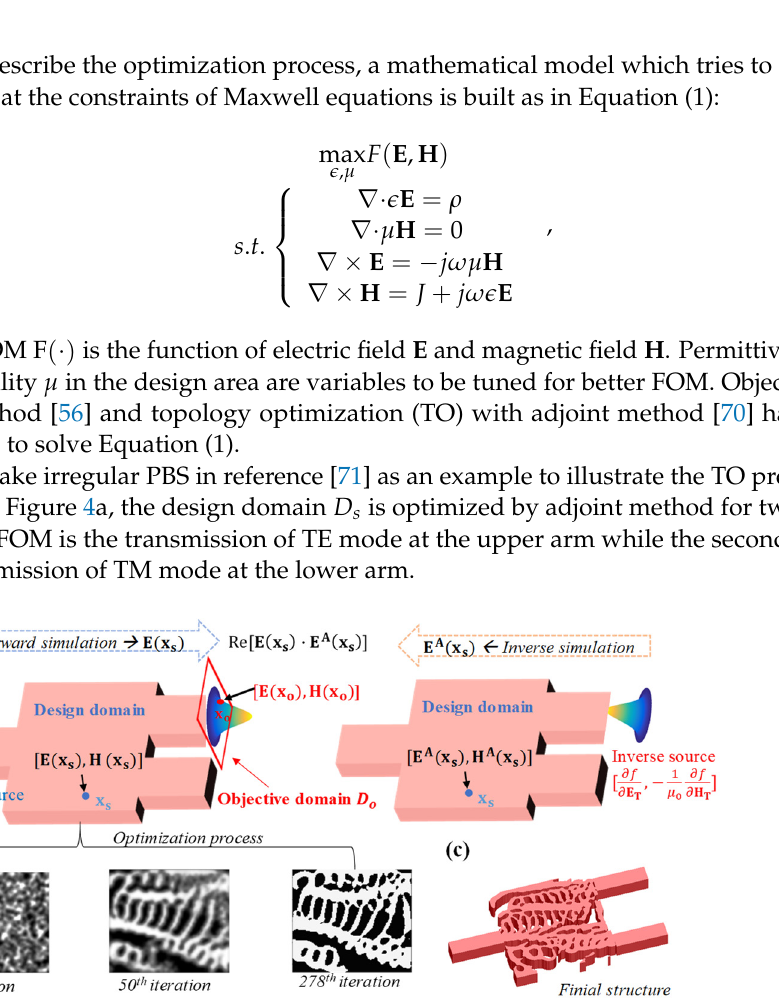
Figure 4. Topology optimization of a PBS via adjoint method. ( a ) Schematic diagram of adjoint method. ( b ) Optimization process for the design area of PBS. ( c ) Final structure of optimized PBS.